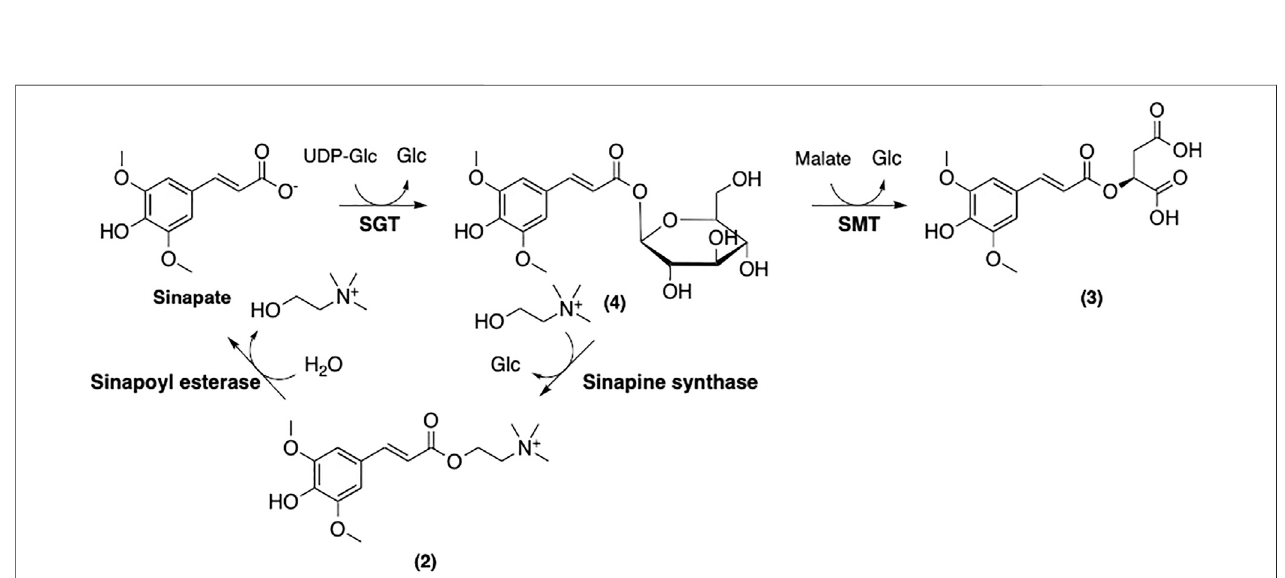
FIGURE 9 | Biosynthetic modi fi cation of sinapate to afford three main SinE in plants.